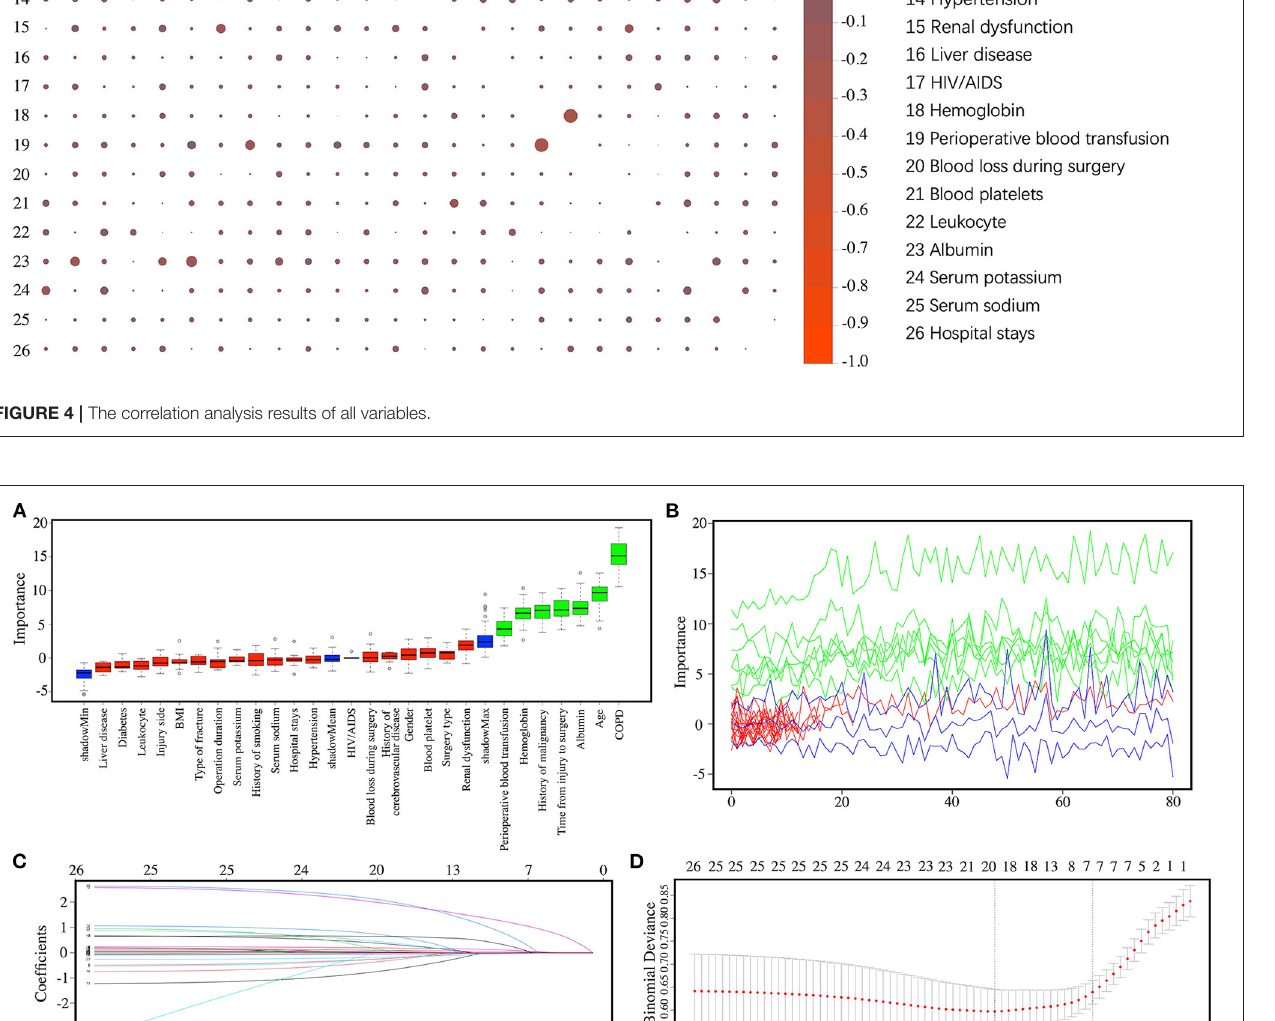
Frontiers in Medicine |